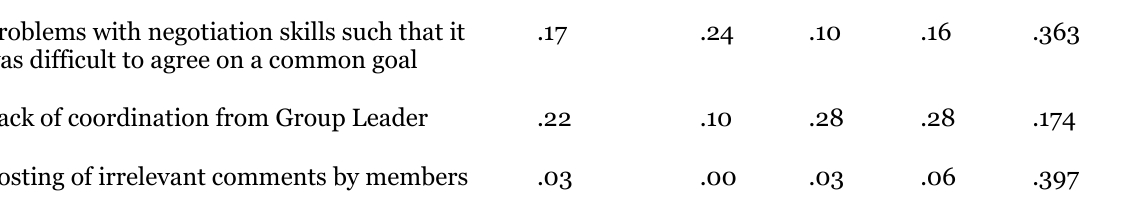
Group outcomes. Table 10 summarizes the group outcomes which include: (a) effectiveness of satisfaction.